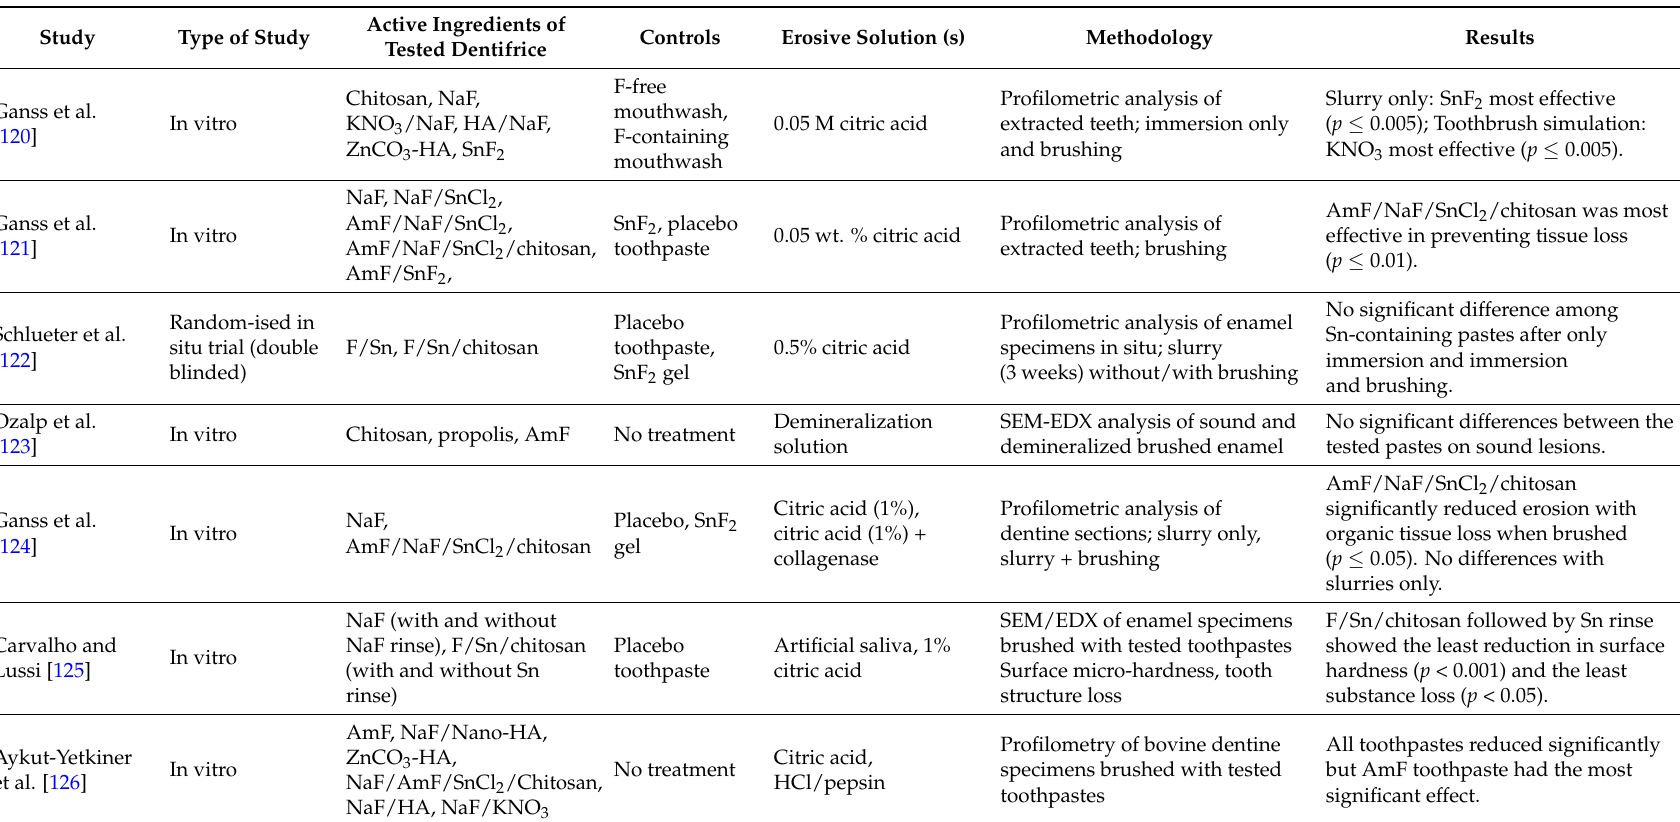
Table 1. Studies reporting effects of chitosan-modified